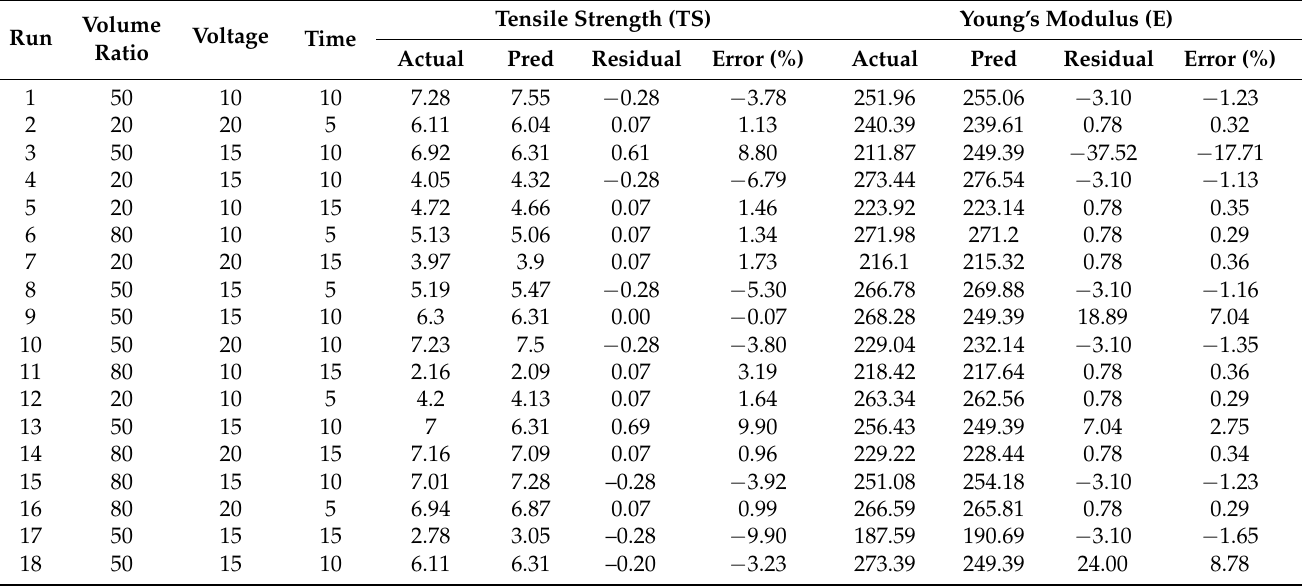
Table 12. Experimental and predicted results of the output response for 20% and 80% experimental water